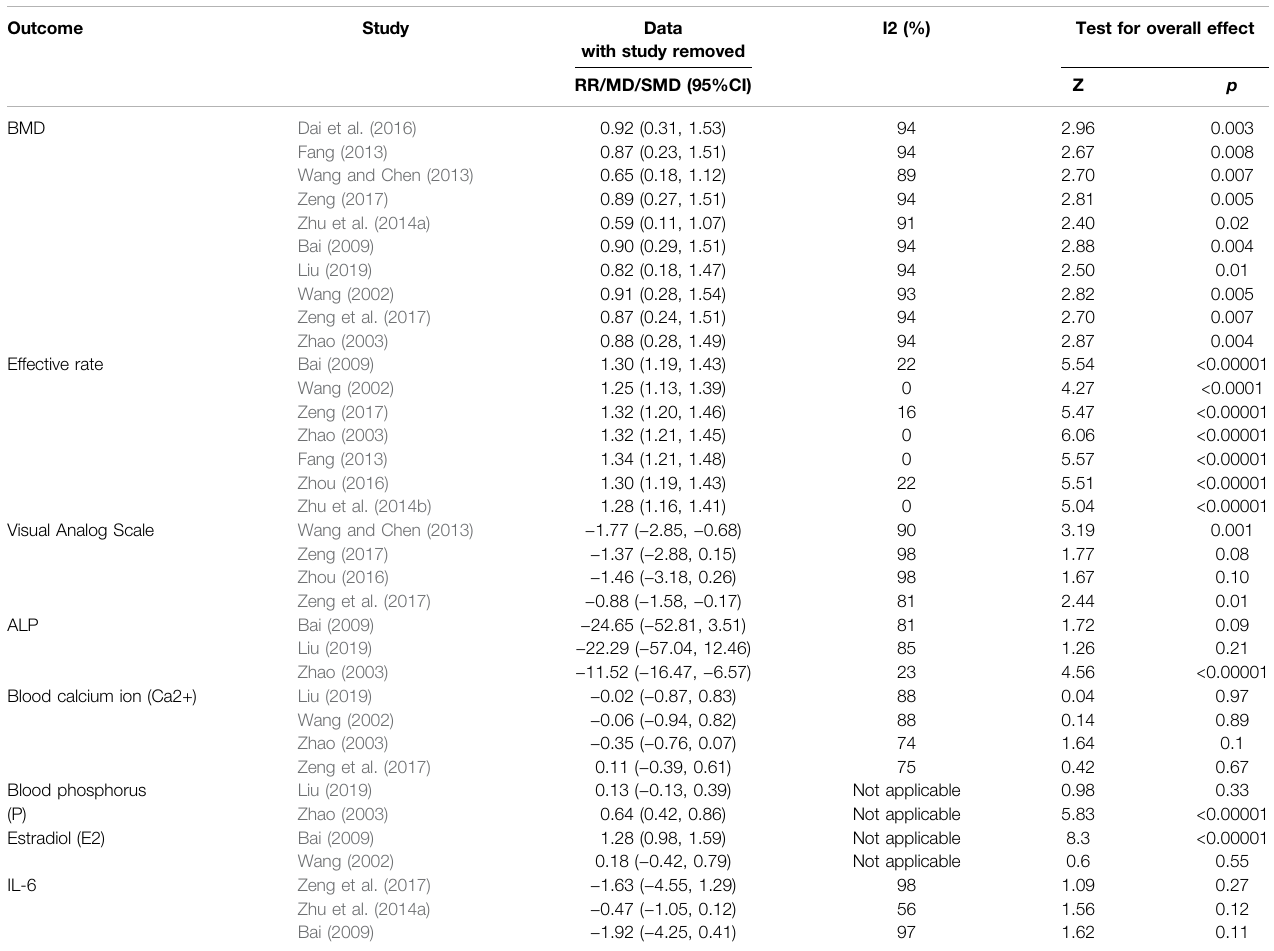
TABLE 5 | Summarized data for sensitivity